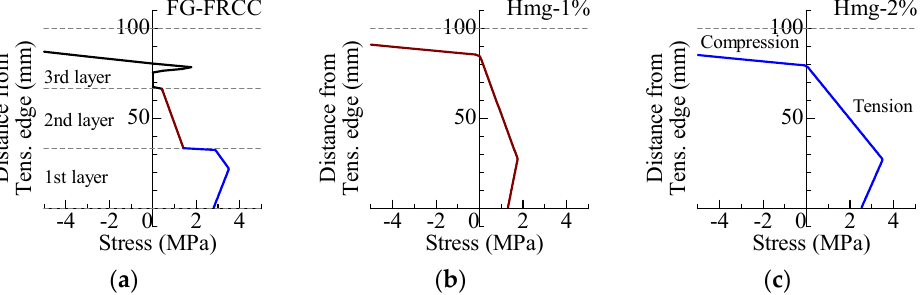
Figure 10. Stress distribution in cross-section at the maximum moment: ( a ) 1st day FG-FRCC; ( b ) 1st day Hmg-1%; ( c ) 1st day Hmg-2%.